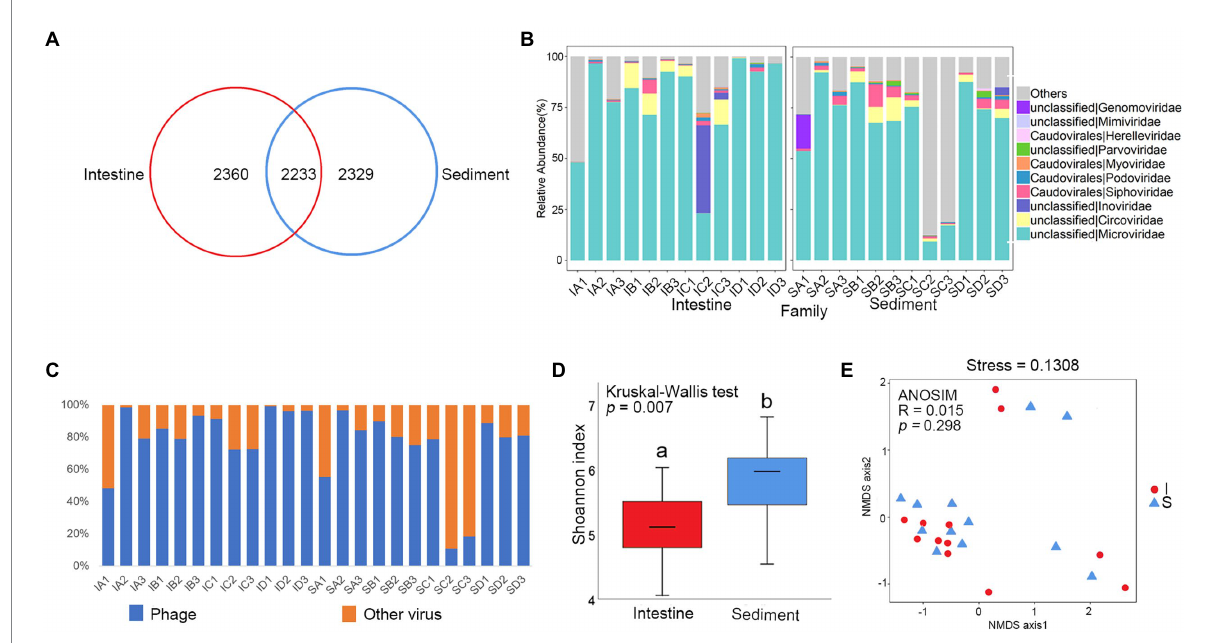
FIGURE 2 Comparative analysis of viral community between shrimp intestine and sediment. (A) Venn analysis of viral communities at the contig level among shrimp intestine (red) and sediment (blue). (B) Relative abundances of dominant viral families. (C) Relative abundances of phage and other viruses. (D) Box plots figure showed the range of Shannon index in shrimp intestine (red) and sediment (blue). The significant difference calculated by the Kruskal-Wallis test was shown by marking a and b. (E) The β -diversity of viral communities of shrimp intestine (red) and sediment (blue) was analyzed by NMDS and ANOSIM based on the Bray-Curtis